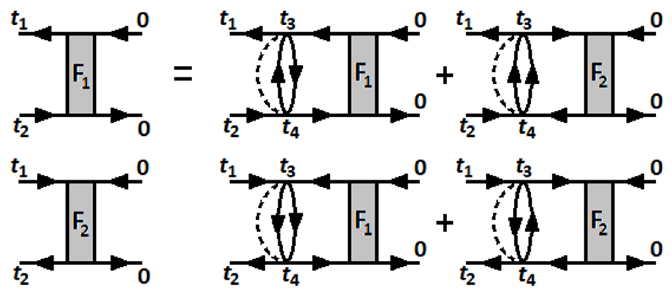
Figure 5. Feynman diagrams for OTOC